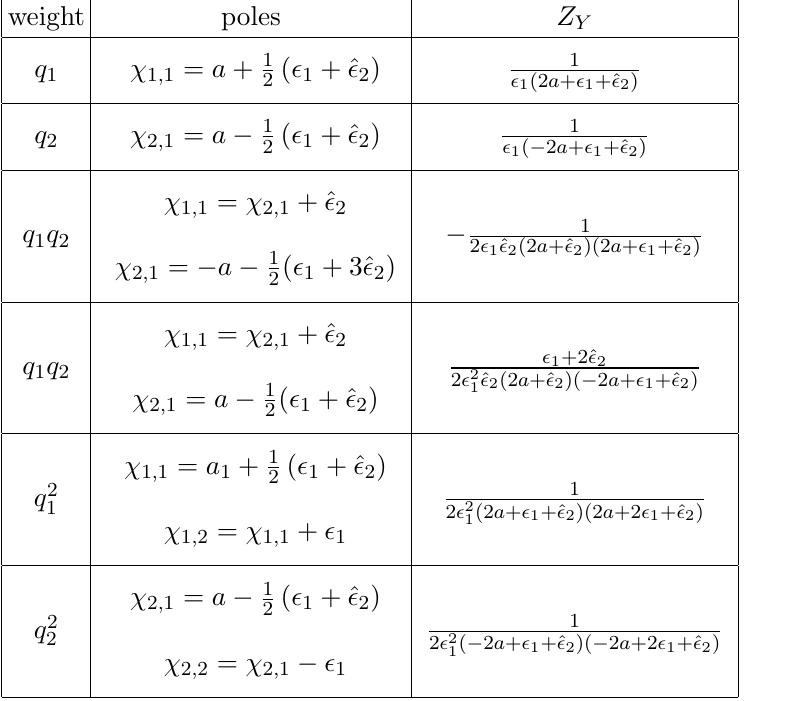
Table 2 . We list the weight factors, the pole structure and the contribution to the partition function in all cases up to two boxes for the SU(2) theory using the contour prescription corresponding to the JK parameter